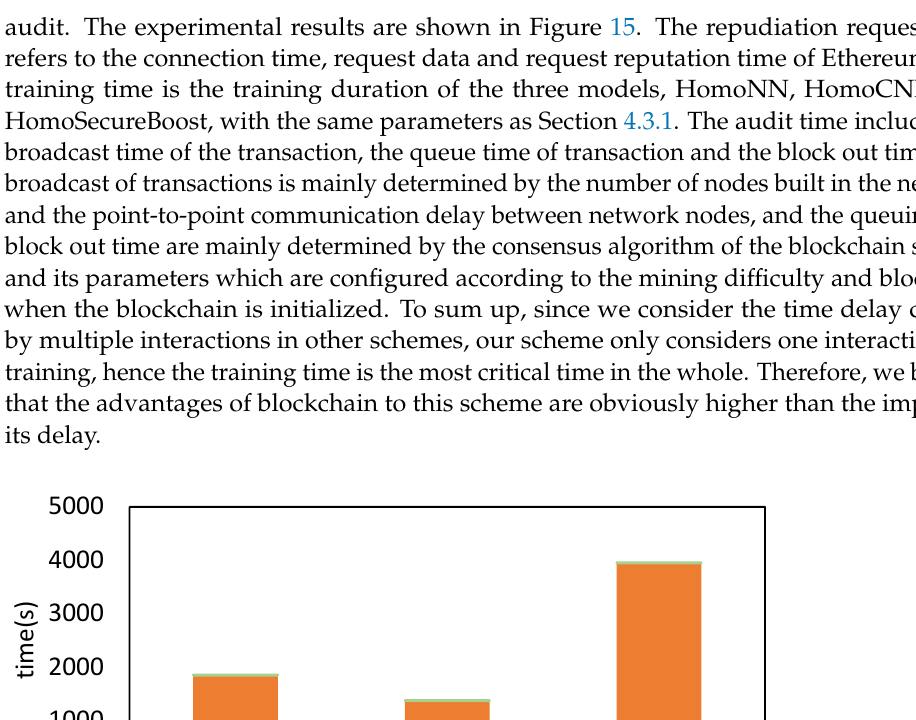
( b ) Figure 17. The update of malicious behavior feature graph: ( a ) Behavior malicious feature graph before update; ( b ) Behavior malicious feature graph after update. 5. Conclusions In this paper, we focus on the reliable application of FL to multi-domain DDoS de- tection. We first introduce a multi-domain DDoS detection method, which realizes the detection of 22 types of DDoS attacks and classifies them into 5 categories, with most of